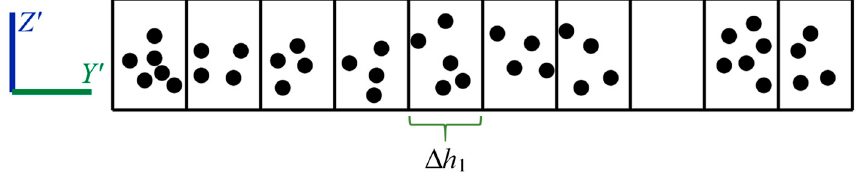
Figure 6. The filling rate is the ratio of the number of smaller bins with points to the number of smaller bins.